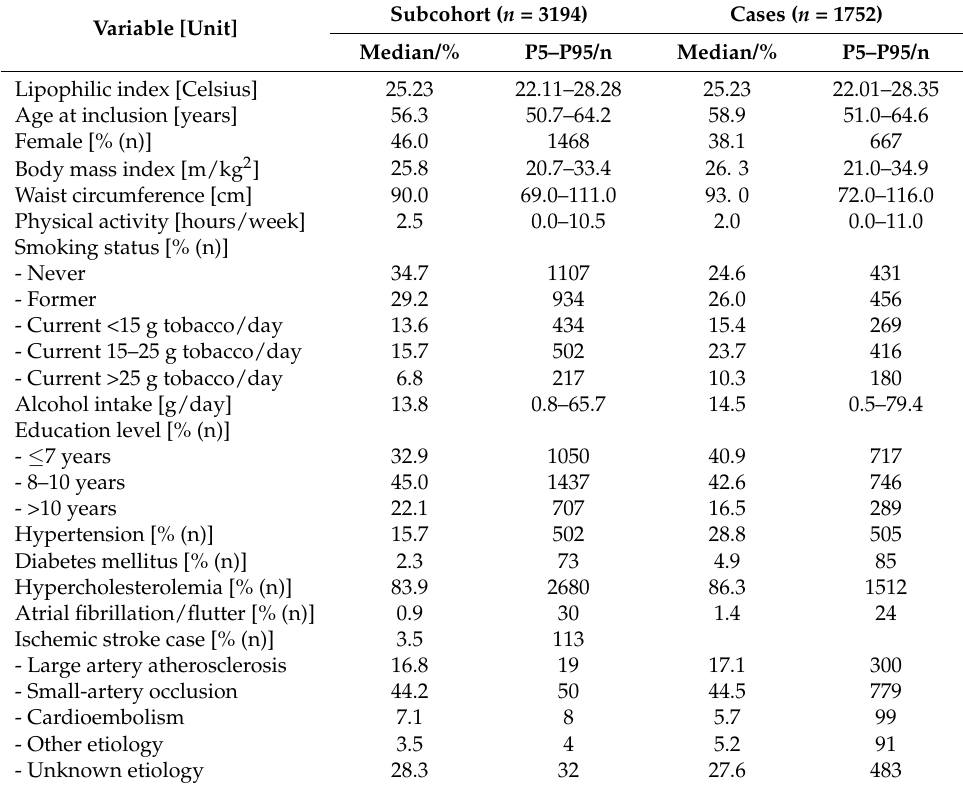
Table 1. Baseline characteristics of cases and subcohort. Numerical values are displayed as median and 5th–95th percentiles (P5–P95) and categorical values as percentages and absolute numbers.